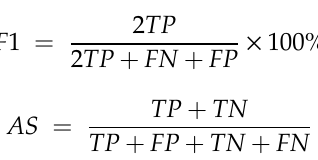
Table 2. Details of datasets used for training and testing the ResNet.